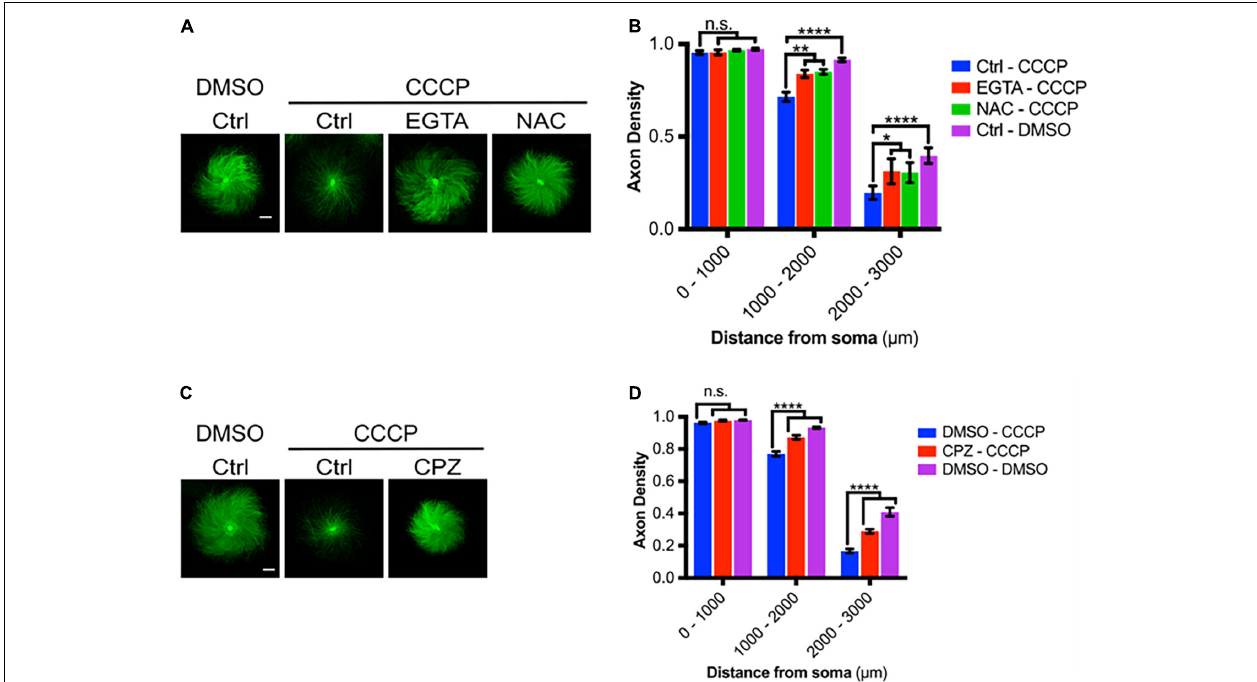
FIGURE 8 | Mitochondrial depolarization leads to axon degeneration. (A) DRGs pretreated with either EGTA (6 mM- 30 min pre-incubation) or NAC (20 mM- 30 min pre-incubation), then treated with CCCP (50 µ M) and immunostained for β -III tubulin (scale bar indicates 1,000 µ m). (B) Axon density of DRGs in radial bins of increasing distance from the central soma ( n = 8 for each group). Values are mean ± SEM. Statistical significance was assessed using a two-factor ANOVA followed by Dunnett’s test relative to CCCP control (Ctrl – CCCP). (C) DRGs pretreated with either CPZ (10 µ M) or DMSO (0.1% v/v), treated with CCCP (50 µ M) and immunostained for β -III tubulin (scale bar indicates 1,000 µ m). (D) Axon density of DRGs in radial bins of increasing distance from the central soma ( n = 9 for each group). Values are mean ± SEM. Statistical significance was assessed using a two-factor ANOVA followed by Dunnett’s test relative to DMSO – CCCP. * p < 0.05, ** p < 0.01, **** p <